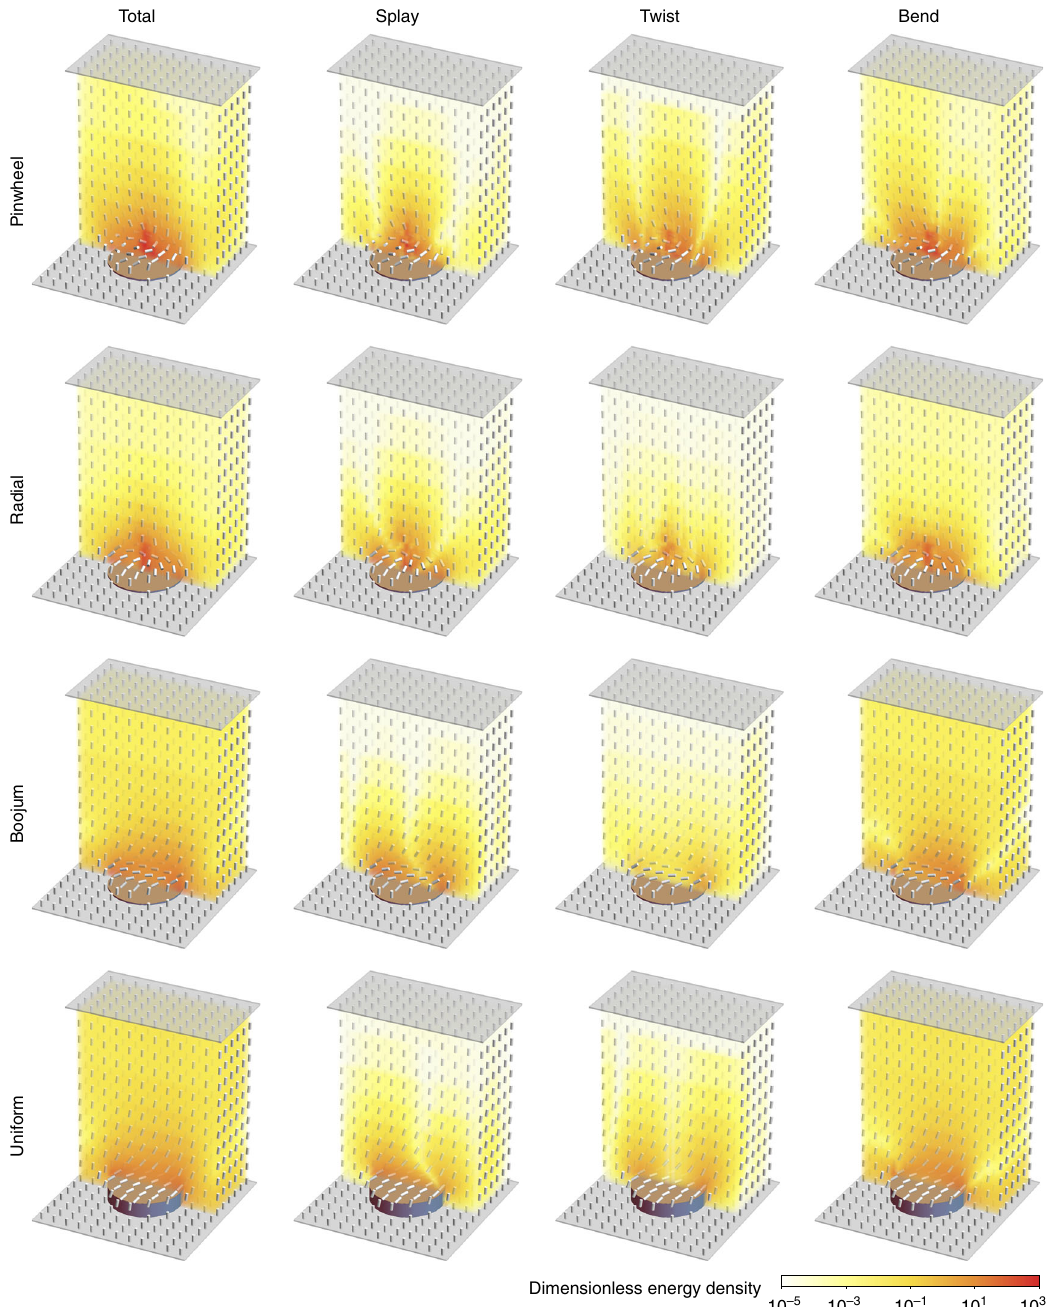
Fig. 2 Simulated molecular alignment con fi gurations. Calculated structures for 5CB on circular SU8 posts, colored by energy density of each elastic deformation mode. Post height is h ¼ 0 : 2 μ m for pinwheel, radial, and boojum structures, and h ¼ 2 μ m for uniform